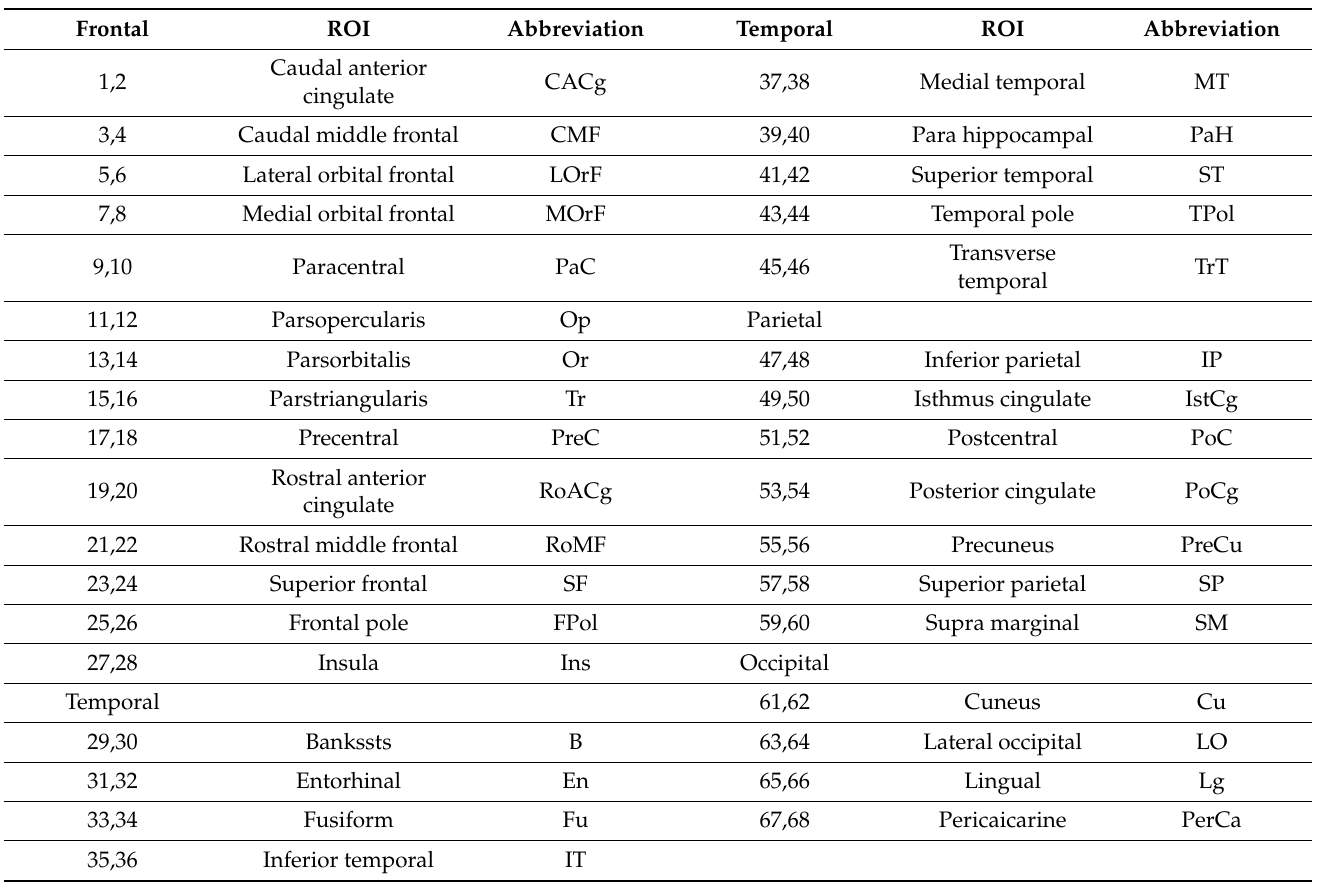
Table 2. Regions of interest (ROIs) and abbreviations of the rearranged Desikan–Killiany atlas. ROIs of the frontal lobe (1-28, odd numbers denote the ROIs in the left hemisphere and even numbers denote the ROIs in the right hemisphere), temporal lobe (29–46), parietal lobe (47–60), and occipital lobe (61–68) are